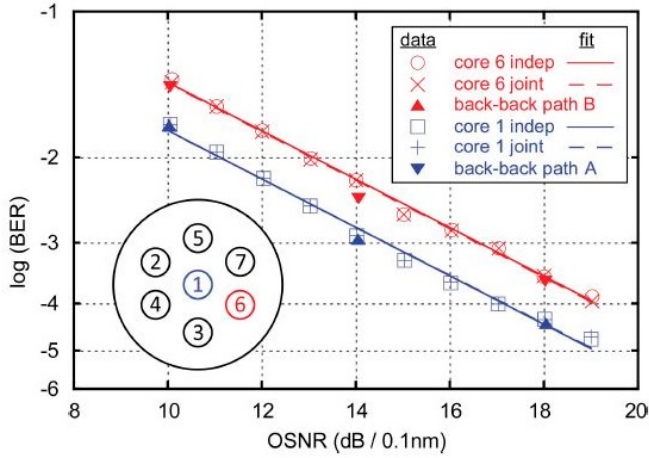
Figure 31. BER vs. OSNR for MCF-based SDM transmission system using the joint DSP scheme [45].